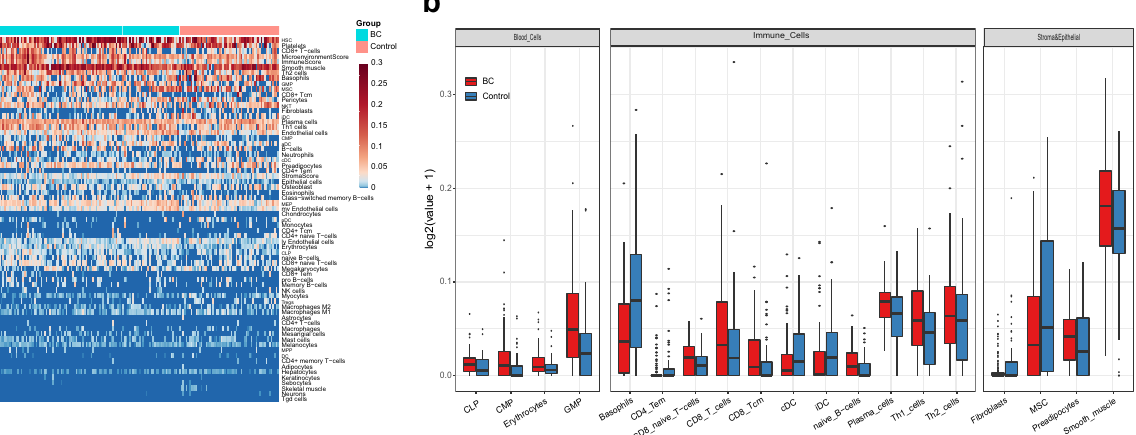
Fig. 2 Relative fractions of different cell types by exLR-seq in BC. a ExLRs re fl ect the relative proportions of different cell types using xCell. Each column represents an individual sample, and each row represents a cell type. The scale represents the relative fractions. b Comparison of different cell types from the exLR-seq data between BC and controls. Only signi fi cant differences between these two groups are